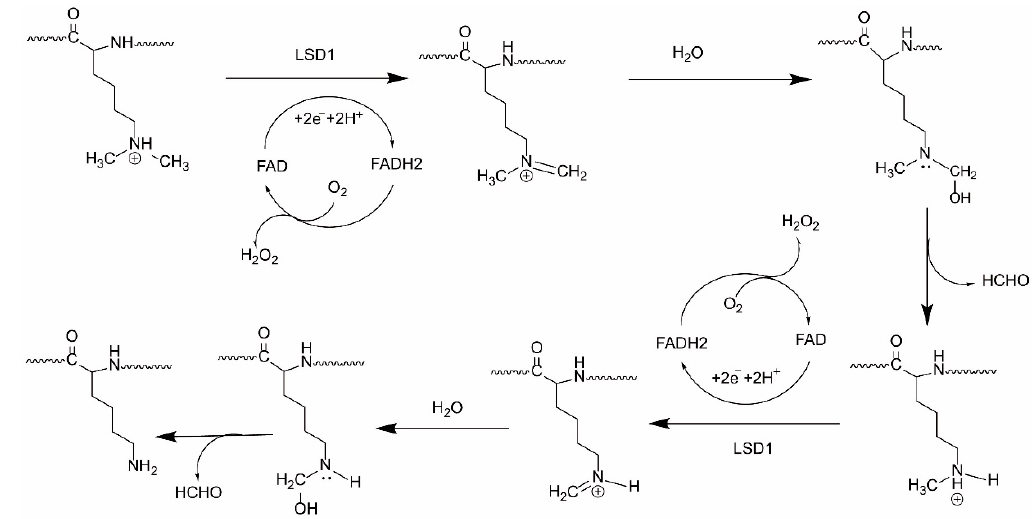
Figure 1. The catalytic mechanism of LSD1.